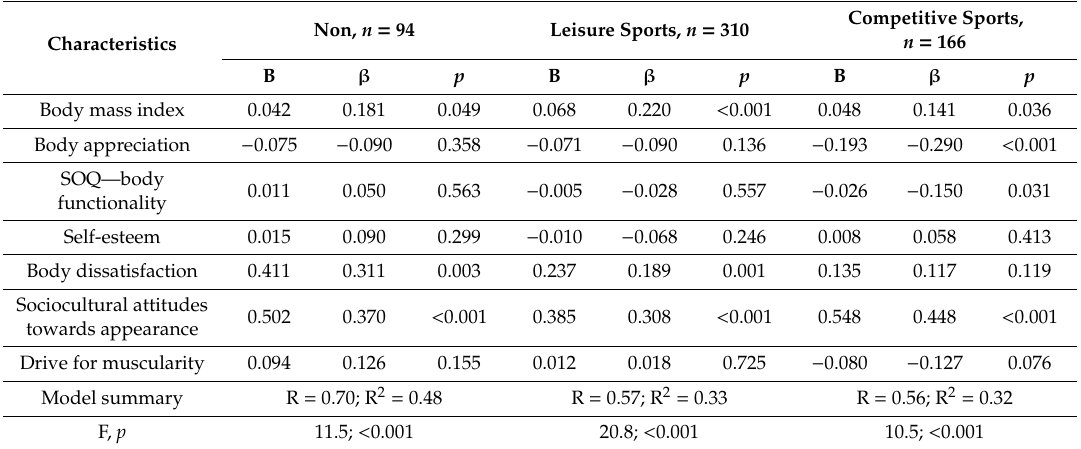
Table 5. Factors associated with higher risk of disordered eating in sports groups in a sample of boys ( n = 570).